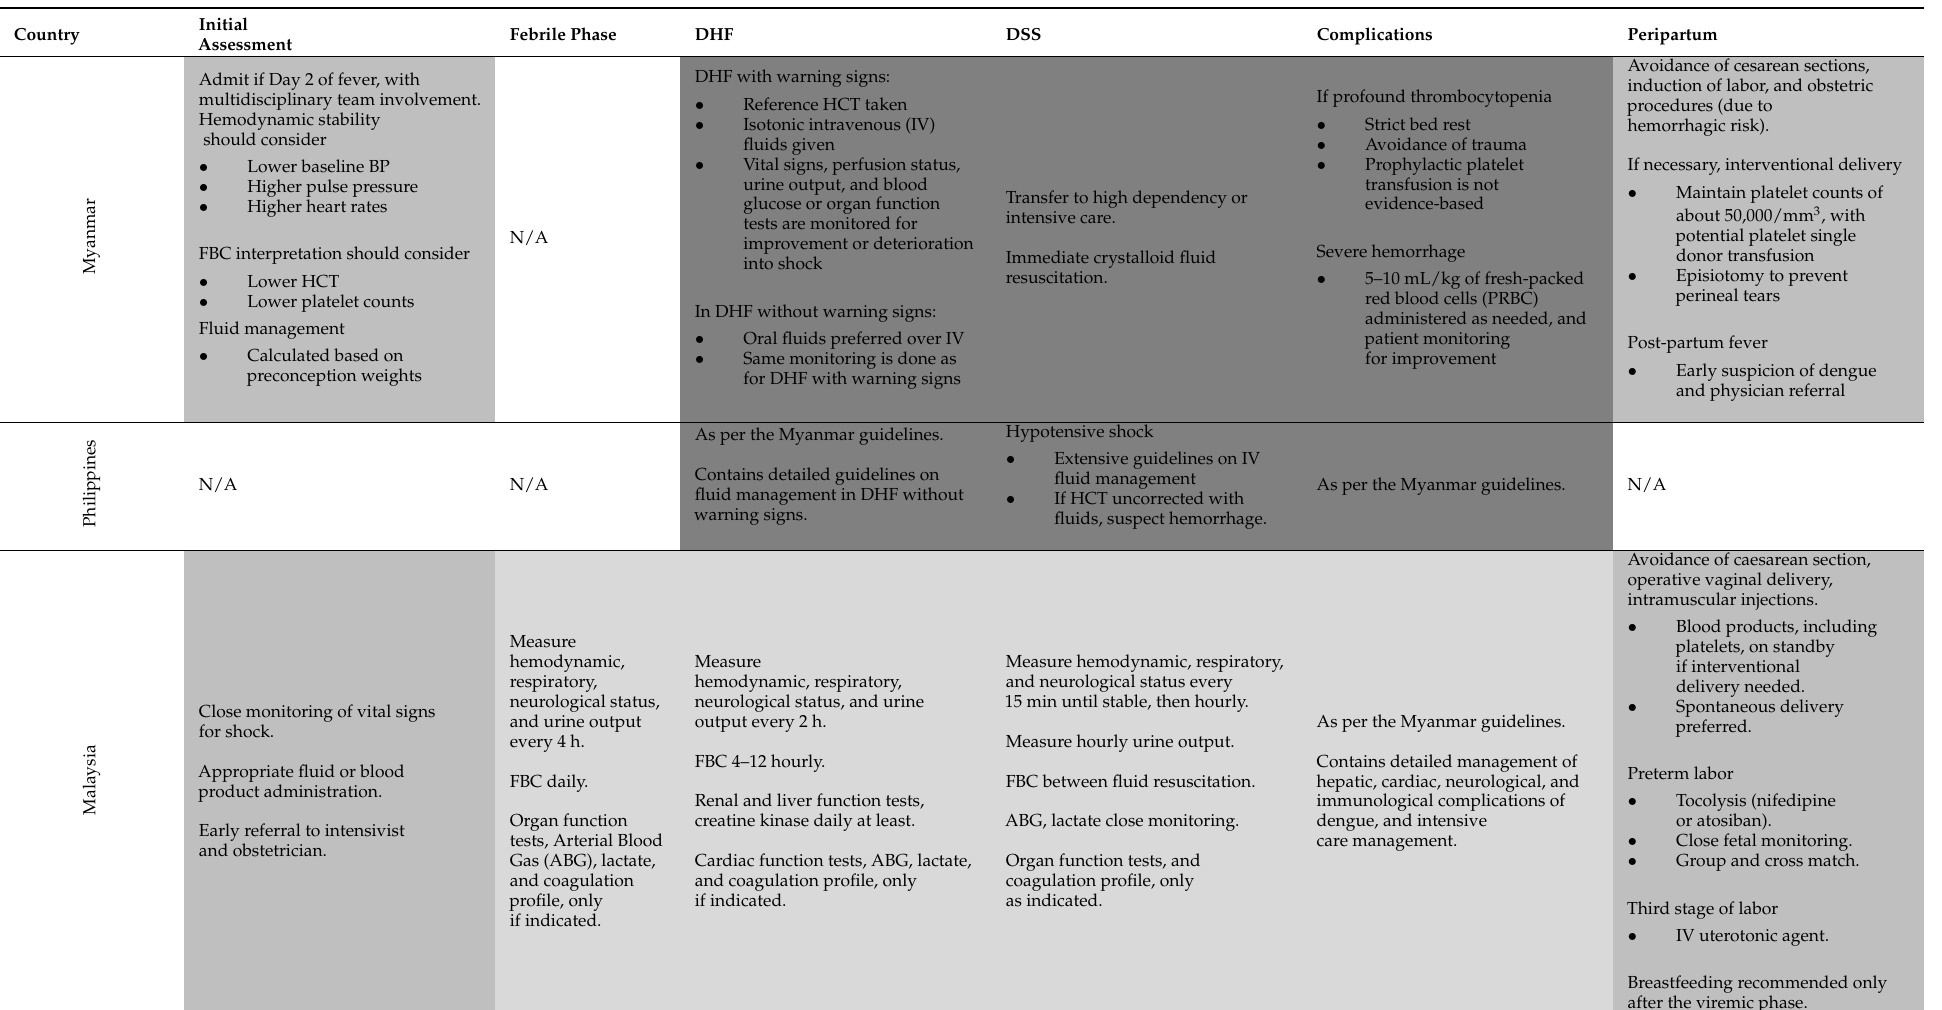
Table 9. Comparison of guidelines from Myanmar [100], the Philippines [99], Malaysia [5], Thailand [90] and Singapore